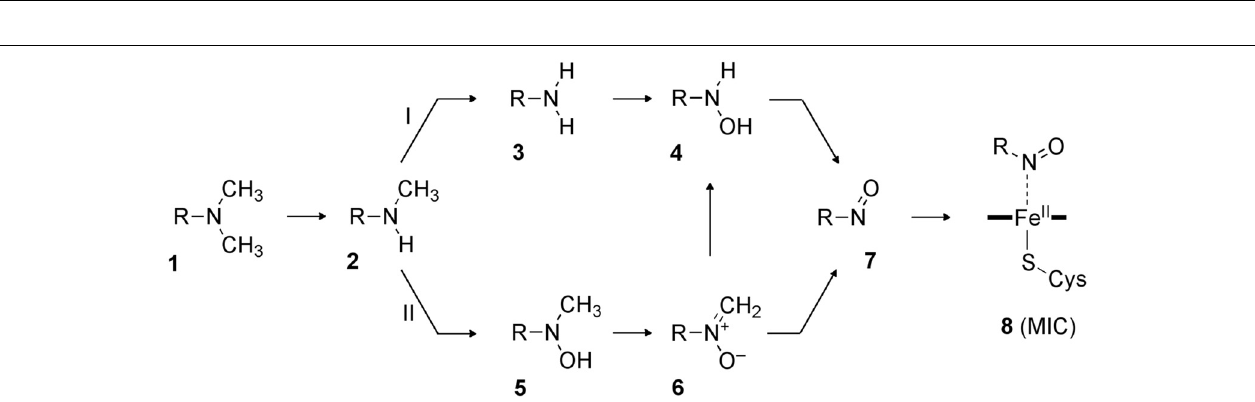
FIGURE 5 | (A) Reaction pathways considered for the MI formation from dimethylhydrazine. (B) Energy profiles (kcal/mol) for the four pathways considered. Adapted from Hirao et al. (2013a) with permission from the Wiley-VCH.